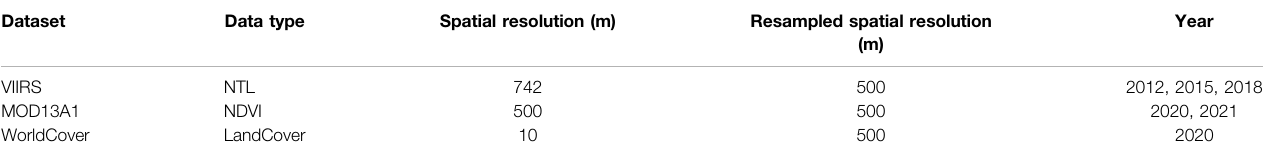
TABLE 1 | Dataset overview. Dataset